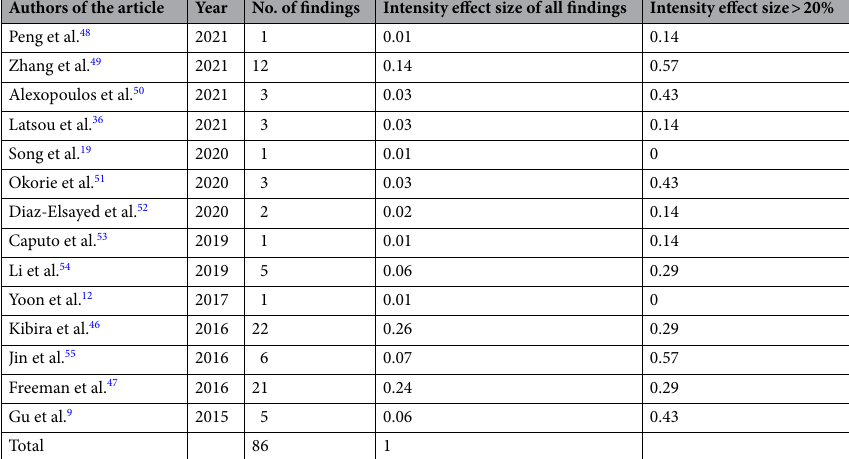
Table 2. List of articles with findings of disruption mentions and their intensity effect sizes of all findings (86 findings) and intensity effect sizes of findings with frequency effect sizes > 20% (7 findings—Table